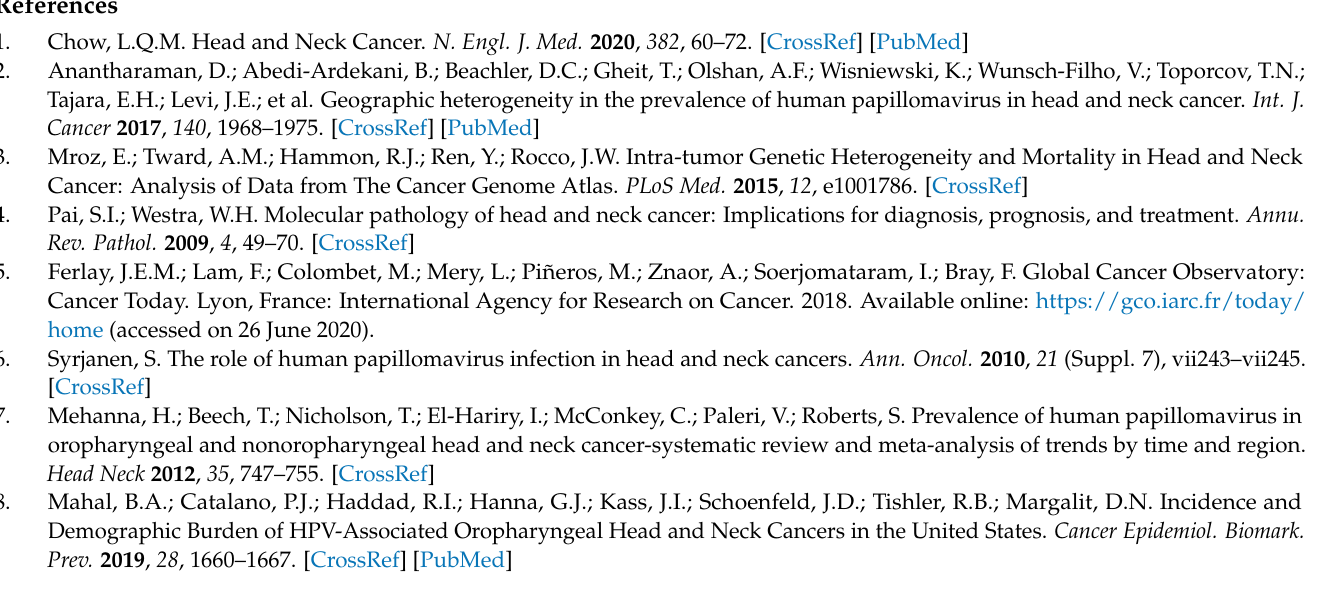
Figure S2: Hierarchical clustering of differentially expressed genes in head and neck squamous cell carcinoma samples from Mexican patients; Table S1: Clinical characteristics of the samples analyzed for expression profiling; Table S2: Differentially Expressed Genes